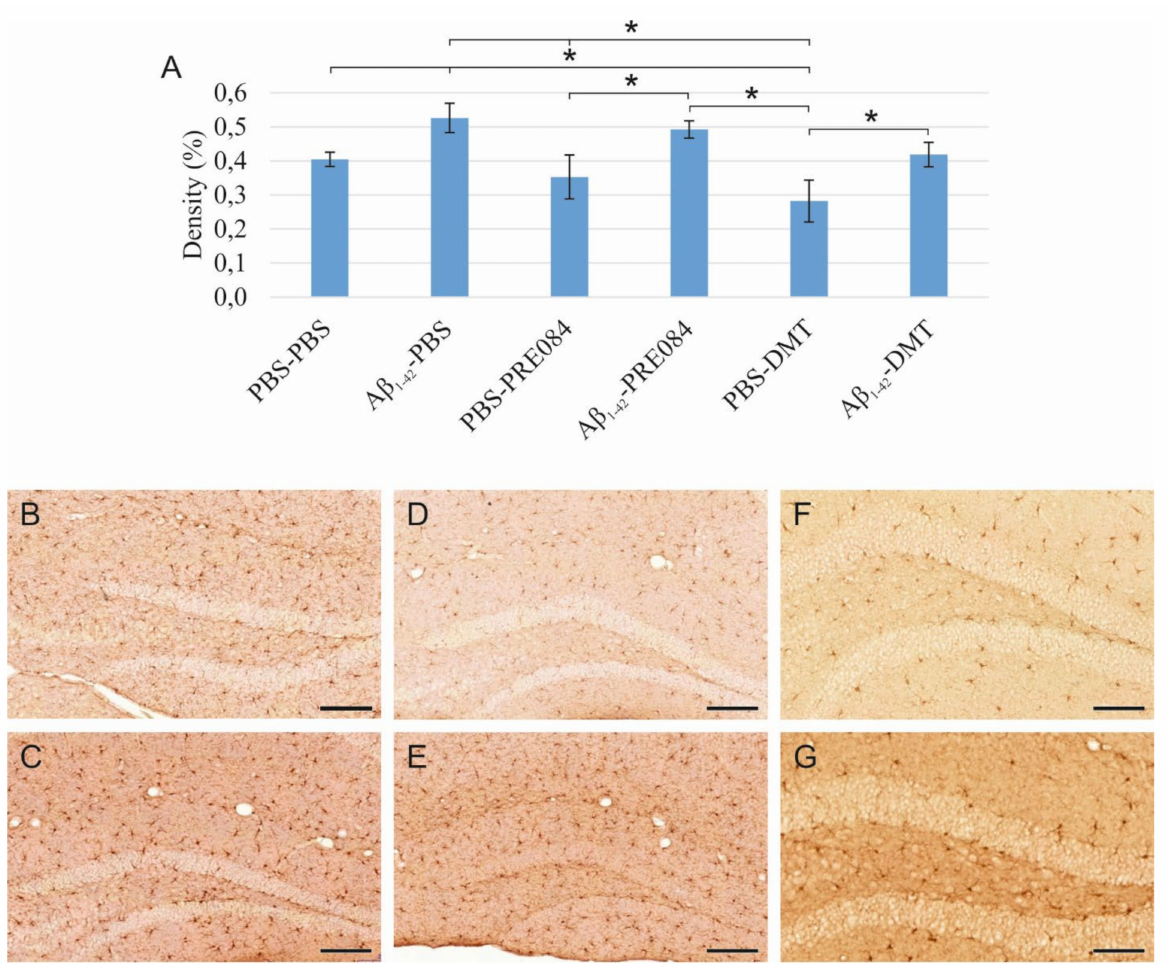
Figure 4. ( A ) Results for ionized calcium-binding adapter molecule 1 (Iba1) immunolabeling. Sig- nificant differences were observed among the groups (ANOVA: p = 0.002). A β 1–42 increased the density of Iba1+ microglia significantly compared to PBS-PBS, PBS-PRE084, and PBS-DMT treated mice, respectively (PBS-PBS vs. A β 1–42 -PBS p = 0.015; PBS-PRE084 vs. A β 1–42 -PRE084 p = 0.035; PBS-DMT vs. A β 1–42 -DMT p = 0.039). The difference between the PBS-PBS and PBS-DMT groups